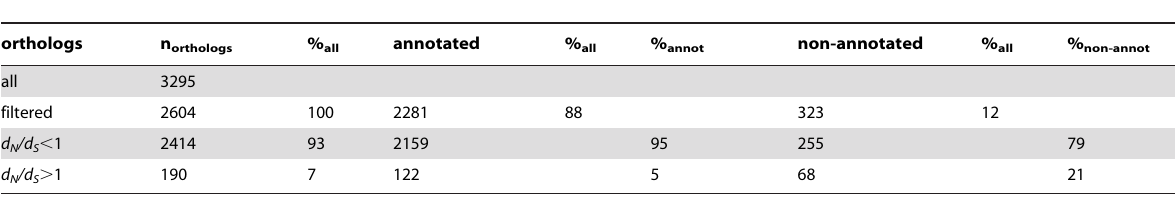
Table 1. Number of annotated (conserved) and non-annotated (presumably lineage-specific) orthologs.